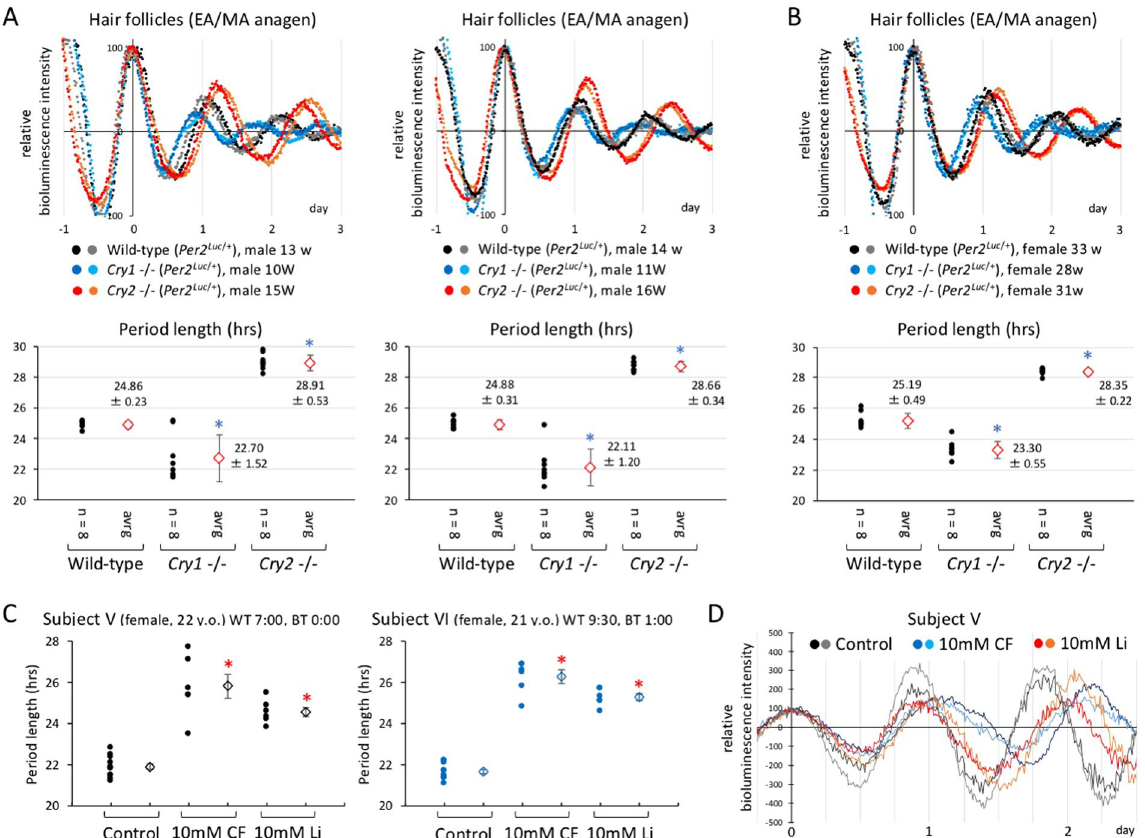
Figure 5. Comparison of circadian period length in whisker follicles among wild-type, Cry1 - and Cry2 - deficient mice. ( A and B ) Whisker hair follicles were isolated by microdissection from wild-type and knockout mice carrying the heterozygous Per2 :: luc allele. The hair cycle stage of whisker follicles was classified by morphology of the hair bulb and relative length of the hair shaft. ( A ) and ( B ) indicate the results obtained from three independent experiments ( A , two sets of young male mice; B , middle-aged female mice). (Upper) After 2-day pre-culture, circadian synchronization was performed with 100 nM dexamethasone (DEX), and bioluminescence was measured in real time with photomultiplier tubes. Data sets were detrended by subtracting the 24 h running average from the raw data, and the first peak was then set to 100. Time 0 was defined as the time of the first peak. (Bottom) Period length calculated with a cosinor analysis. Black dots indicate the calculated period length of each hair follicle, and red dots represent the mean ± SD of period length values. Asterisks indicate a significant difference from wild-type (t test, P < 0.05). ( C and D ) The effect of 10 mM caffeine and lithium on the autonomous circadian oscillator in hair tissue from two human subjects. Chronic treatment with these reagents was started after removal of the adenovirus carrying Per3-luc from the culture medium. ( C ) Period length was calculated by cosinor analysis. Filled dots indicate the calculated period length of individual hair follicles, and open dots represent the mean ± SE. Asterisks indicate a significant difference compared to wild-type (t test, P < 0.05). ( D ) A representative set of bioluminescence data that were detrended by subtracting the 24 h running average from the raw data. The first peak was then set to 100. Time 0 was defined as the time of the first